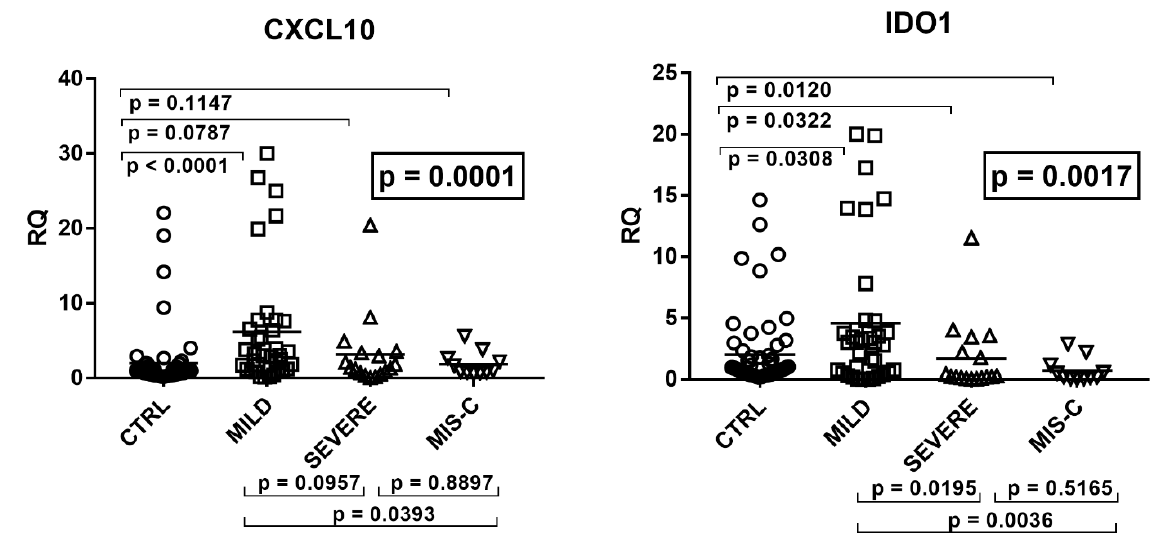
Figure 2. Expression of type II interferon and of CXCL9, CXCL10, and IDO1 in whole blood from 64 children with SARS-CoV-2 infection and 60 uninfected children. CTRL: uninfected control children. MILD: infected children with mild/moderate symptoms. Severe: infected children with severe disease. MIS-C: infected children with multisystem inflammatory syndrome. RQ: relative quantification. Circles, squares, and triangles show the mean of three individual measurements, horizontal lines the median values. Median values–interquartile range (IQR) of IFN- γ and its sensitive genes: IFN- γ : CTRL: median 0.98, IQR 0.56, 1.37; MILD: median 3.23, IQR 1.45, 4.59; SEVERE: median 2.02, IQR 1.17, 3.92; MIS-C: median 0.80, IQR 0.44, 0.93. CXCL9: CTRL: median 1.03, IQR 0.71, 1.58; MILD: median 0.91, IQR 0.55, 1.46; SEVERE: median 0.56, IQR 0.22, 1.12; MIS-C: median 0.71, IQR 0.37, 0.95. CXCL10: CTRL: median 0.78, IQR 0.51, 1.32; MILD: median 3.00, IQR 1.21, 6.82; SEVERE: median 1.41, IQR 0.67, 3.35; MIS-C: median 0.94, IQR 0.75, 2.40. IDO1: CTRL: median 0.82, IQR 0.43, 1.80; MILD: median 3.00, IQR 0.56, 4.23; SEVERE: median 0.24, IQR 0.15, 2.20; MIS-C: median 0.21, IQR 0.10, 0.86. Statistical analysis: one-way ANOVA was used to compare the transcriptional levels of each target between the four groups of children. The Mann–Whitney test was used to compare the transcriptional levels of each target between each group of children with each other.